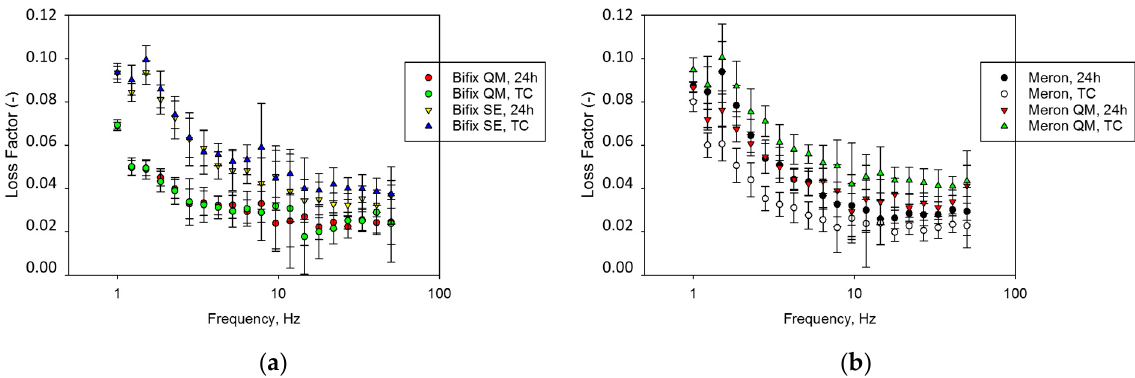
Figure 6. Variation of the loss factor (tan δ ) over the frequency range 1–50 Hz for ( a ) Bifix QM and Bifix SE; ( b ) Meron and Meron QM.